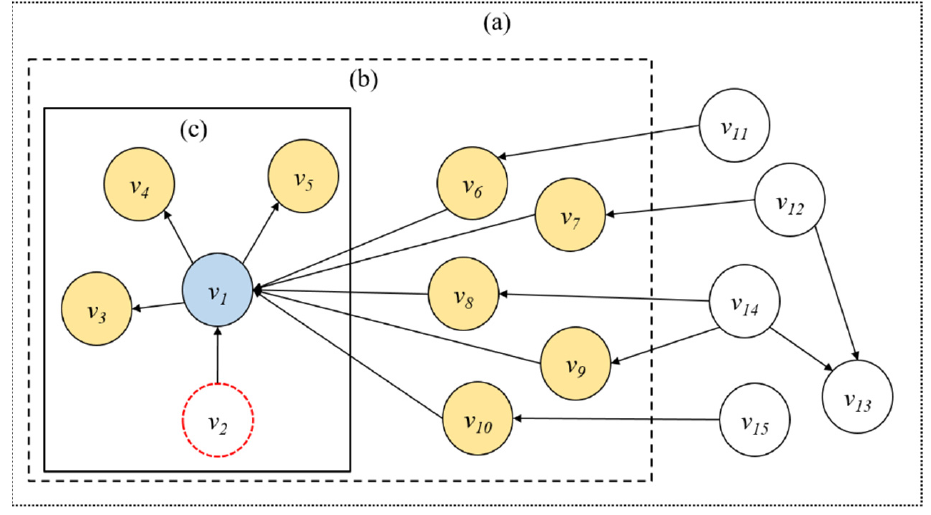
Figure 2. Processing ratio.